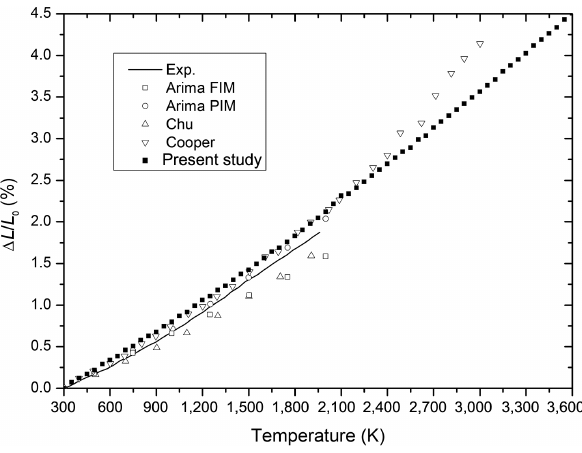
Figure 2: Evolution of relative linear thermal expansion of present results, MD data and experimental data with temperature.